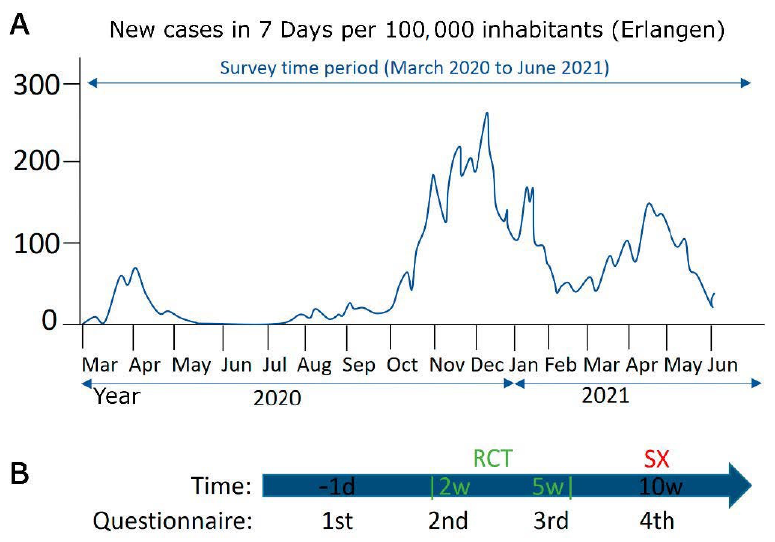
Figure 1. ( A ) The number of new cases in seven days per 100,000 inhabitants in Erlangen from March 2020 to June 2021. ( B ) The timeline corresponds to the period in which the patient received the ques- tionnaire and in which therapy stage the patient was at (RCT = radiochemotherapy; SX = surgery). The patient cohort consisted of 389 patients with rectal cancer, including 350 patients before COVID-19 and 39 during COVID-19. The proportion of male and female patients before the pandemic was 70.6% and 29.4%, respectively. During the pandemic, the pro- portion of male patients was 59% and the proportion of female patients was 41%. Most patients were in advanced tumor stages. The proportion of patients at cT3 stage for non- COVID-19 was 65.4% and 65.0% for COVID-19, and the proportion of patients at cT4 stage for non-COVID-19 was 25.5% and 24.0% for COVID-19 (Table 1). The average age was 62.5 years, with the youngest age being 15 years and the oldest 86 years. The higher the functional score, the better, because it means that the patient has more functional abilities in that category. Functions before the COVID-19 pandemic were com- pared with those during the COVID-19 pandemic (Figure 2A). Non-COVID-19 patients had the highest mean scores for cognitive functioning (84.1%), physical functioning (78.6%), body image (72.9%), and sexual functioning (72.6%) and the lowest mean scores for future outlook (35.9%) and global health (59.1%) at baseline on day-1 radiochemother- apy (Figure 2A). During the COVID-19 pandemic, functional scores were highest for sex- ual functioning (84.3%) and cognitive functioning (72.6%) and lowest for future perspec- tive (33.3%) and global health (46.4%). During the COVID-19 pandemic, scores for role function ( − 17.4 pp), global health status ( − 12.7 pp), cognitive function ( − 11.4 pp), physical function ( − 10.4 pp), and social function ( − 10.0 pp) decreased the most ( p < 0.045). Emo- tional functioning decreased by 7.7 pp; future outlook ( − 2.6 pp) and body image (0.5 pp) did not change. The only functional score that did not decrease was sexual function, which increased from 72.6% to 84.3%.